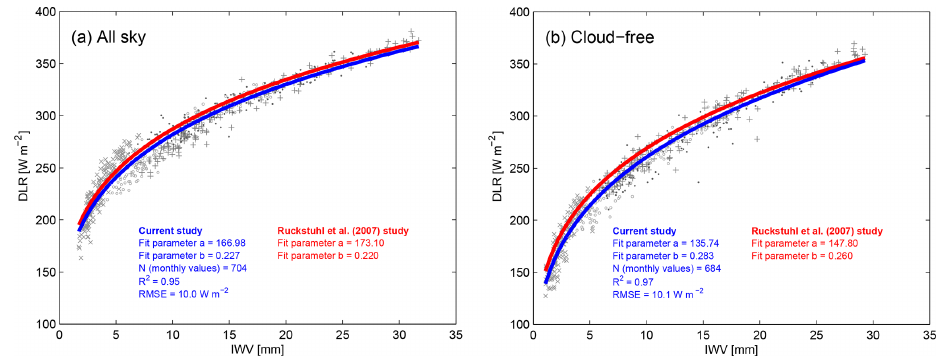
Figure 4. Monthly average DLR at all four stations (symbols: LOC is plus symbols, PAY is closed circles, DAV is open circles, and JFJ is crosses) for the 2000–2015 period versus IWV values during (a) all-sky conditions and (b) cloud-free